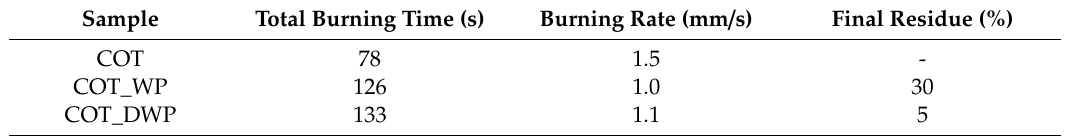
Table 2. Horizontal flame spread data for untreated and treated cotton